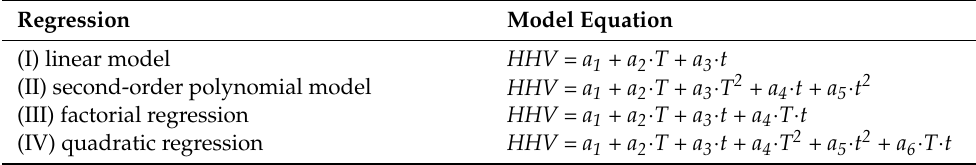
Table 2. Regression models applied to describe the dependence of higher heating value (HHV) of carbonized solid fuel (CSF) produced from different RDF components to the pyrolysis temperature ( T ) and residence time ( t ).